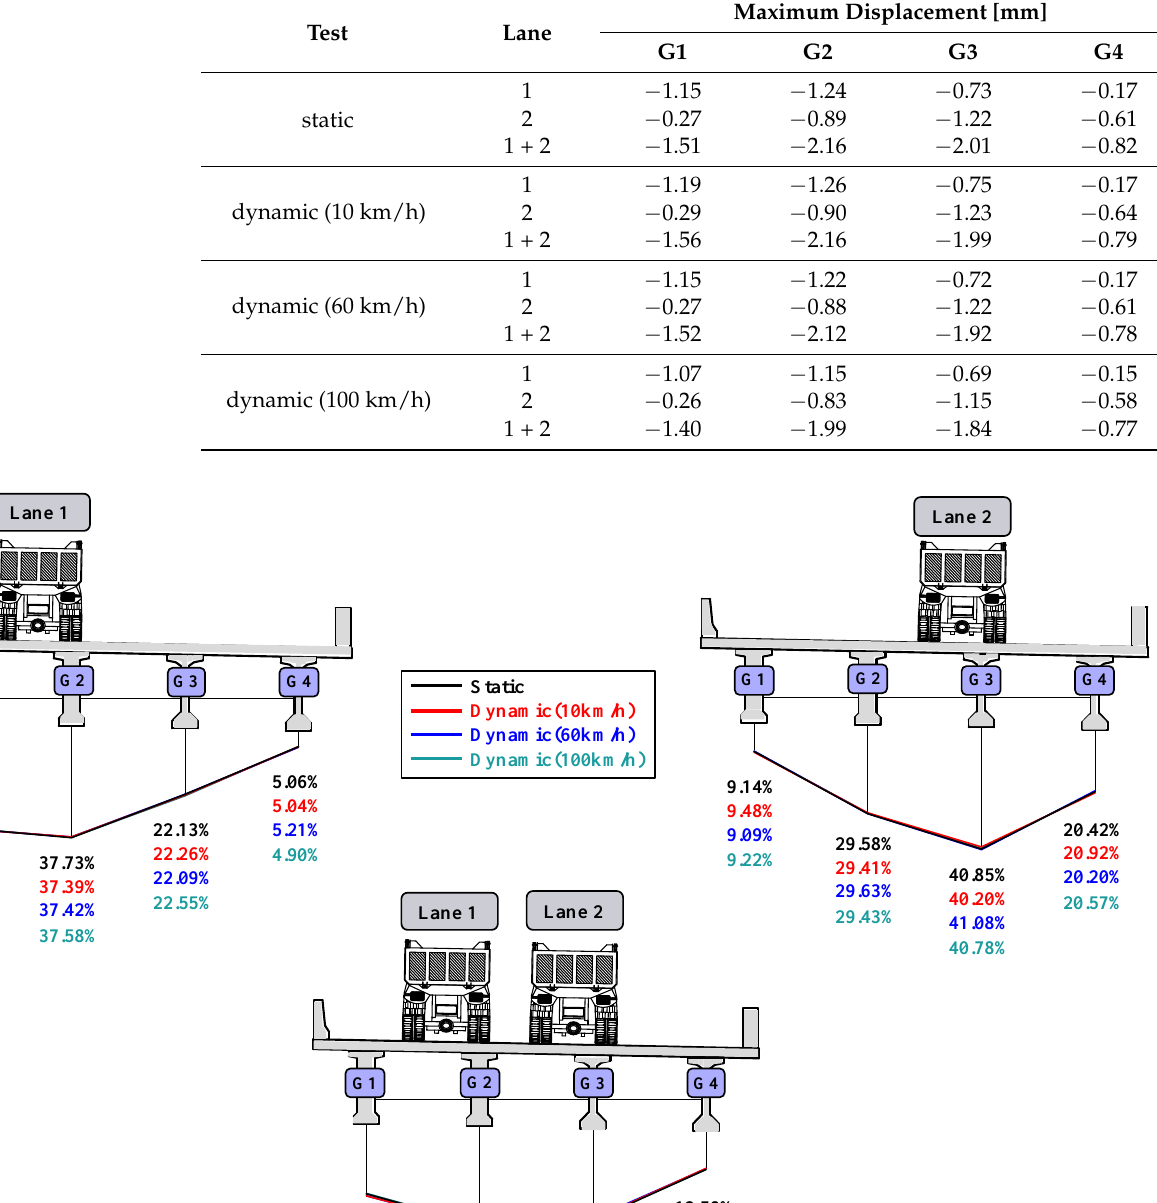
Table 3. Maximum displacement measured in each LC.